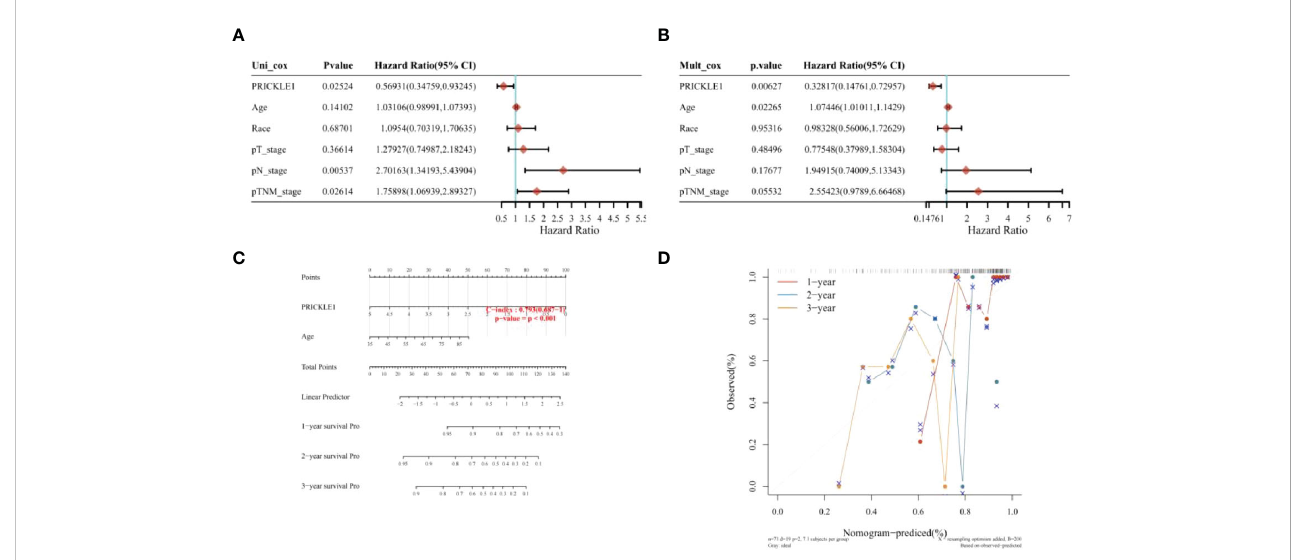
FIGURE 3 Nomogram construction (A) single-factor COX risk regression model; (B) multi-factor COX risk regression model; (C) column line graph predicting patient survival; (D) calibration curve showing the predictive performance of PRICKLE1 on patient survival at 1, 2 and 3